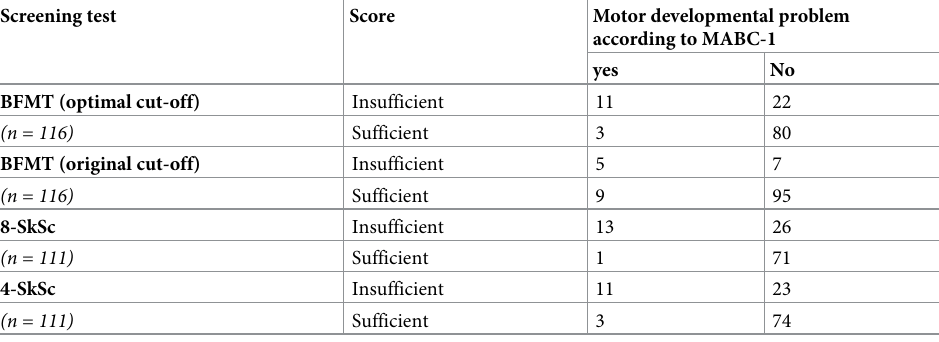
MABC: Movement Assessment Battery for Children; BFMT: Baecke Fassaart Motor Test; Skills Scan SkSc